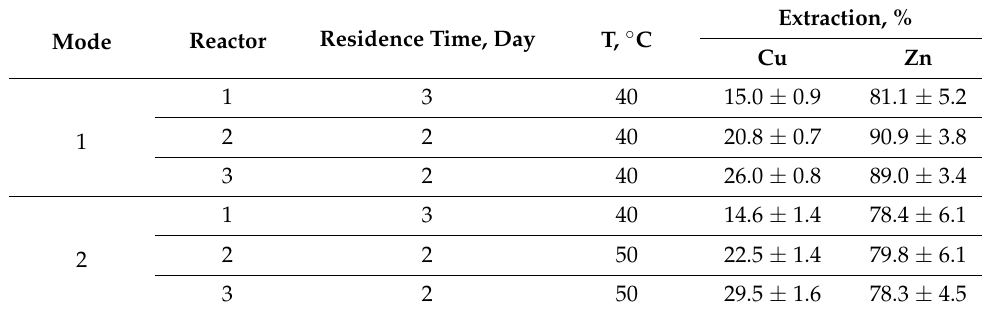
Table 3. Metal extraction into the liquid phase during